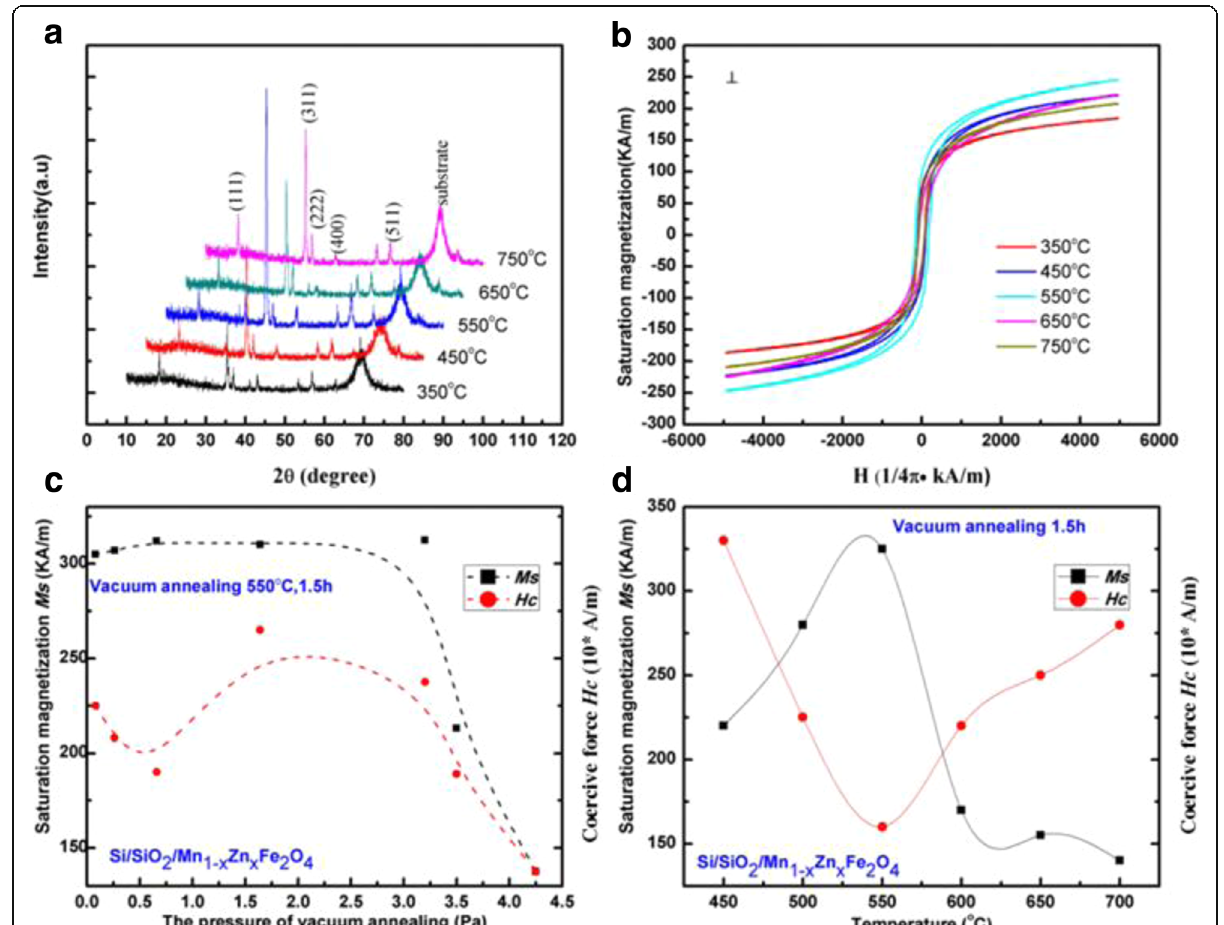
Fig. 3 Characterization of sputtered MnZn thin films. ( a ) XRD patterns and ( b ) hysteresis loops of MnZn thin films annealed at 350, 450, 550, 650, and 750 °C. Saturation magnetization ( Ms ) of the MnZn thin films when annealed under the pressure from 0.0 Pa to 4.5 Pa in ( c ) and temperature from 450 to 700 °C in ( d